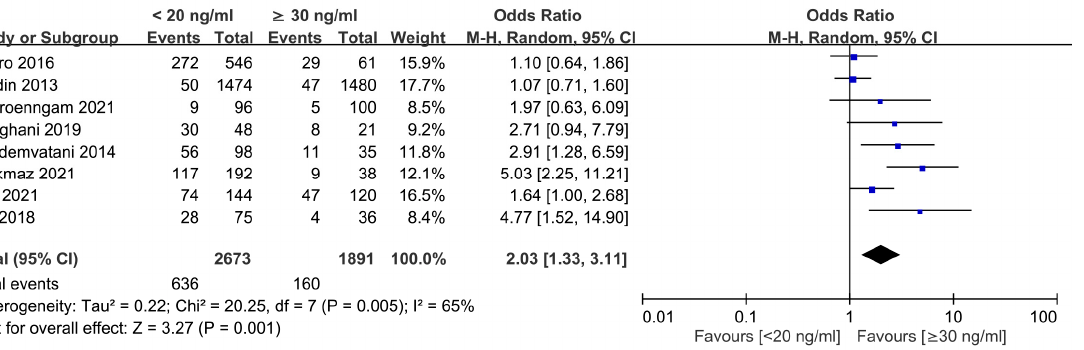
Figure 5. Subgroup analysis comparing the risk of venous thromboembolism between individuals with vitamin D deficiency and those with a normal vitamin D status. CI, confidence interval; M-H, Mantel-Haenszel. The measure of effect (e.g., an odds ratio) for each of these studies is represented by a square incorporating confidence intervals represented by horizontal lines. The vertical line is “Line of no effect”. The area of each square is proportional to the study’s weight in the meta-analysis. This meta-analysed measure of effect is plotted as a diamond, the lateral points of which indicate confidence intervals for this estimate [18,19,28–30,35,38,39].